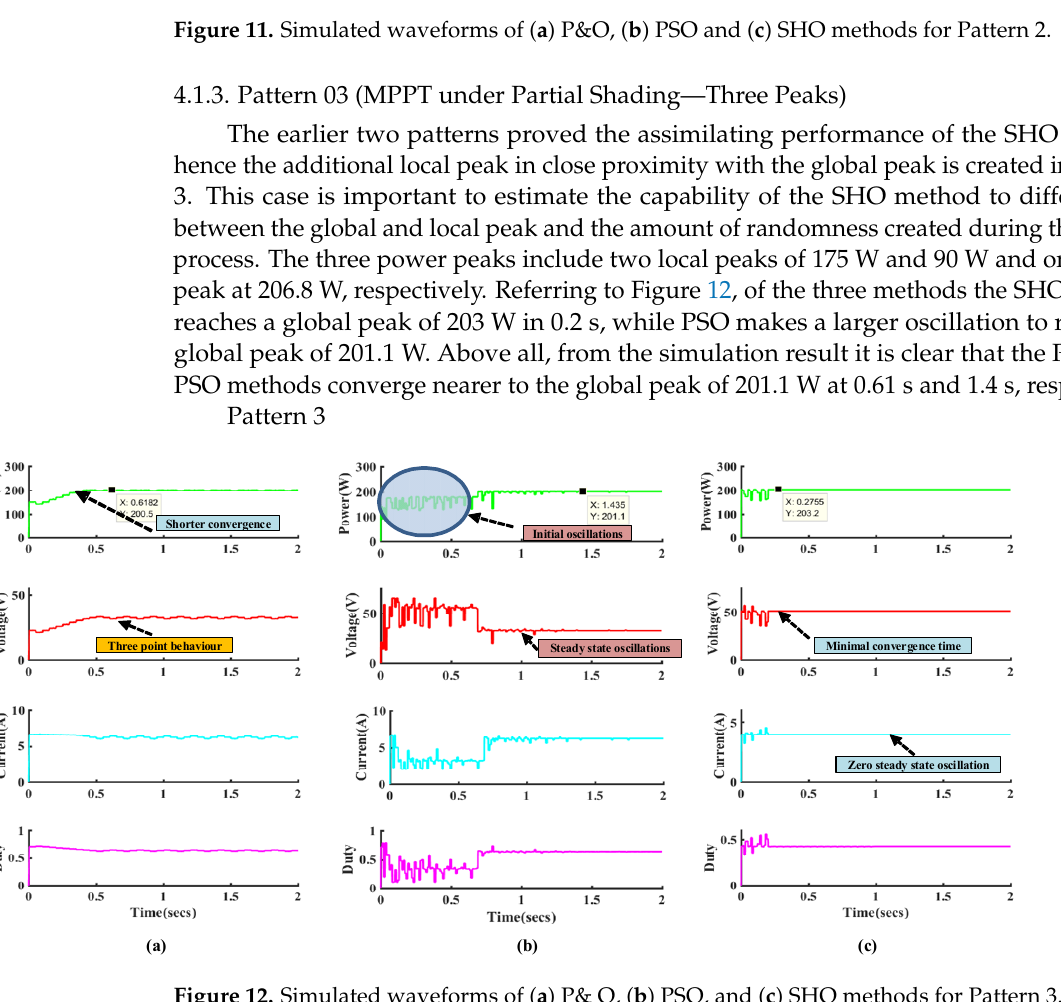
Figure 12. Simulated waveforms of ( a ) P& O, ( b ) PSO, and ( c ) SHO methods for Pattern